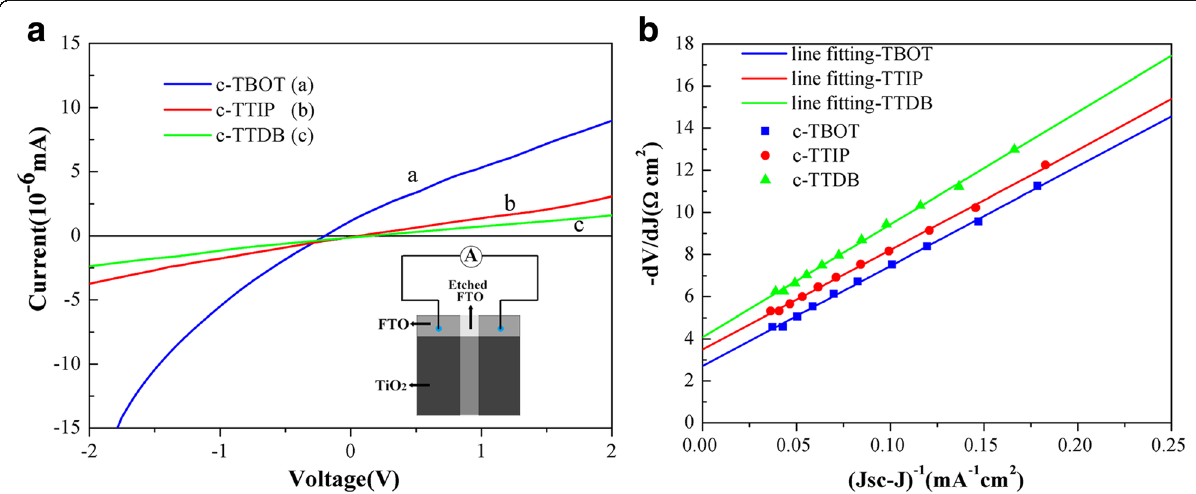
Fig. 4 a Conductivity measurement results of various c-TiO 2 . The inset depicts the structure of the sample. b Plots of − dV/dJ vs ( J sc - J ) − 1 derived from J - V curves and the linear fitting